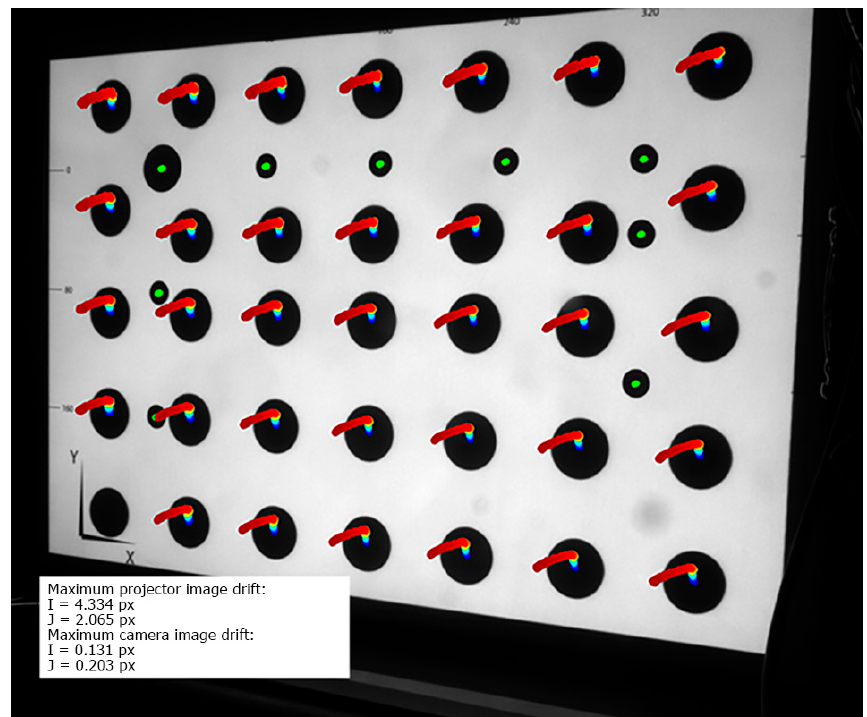
Figure 8. Thermal image drift of the DLP Casio XJ-A252 during the warming-up process. The marker trajectories are multiplied 20 times. The colors show the temperature of the projector (blue dot: temperature around 24 °C , red dot: temperature around 41 °C ).